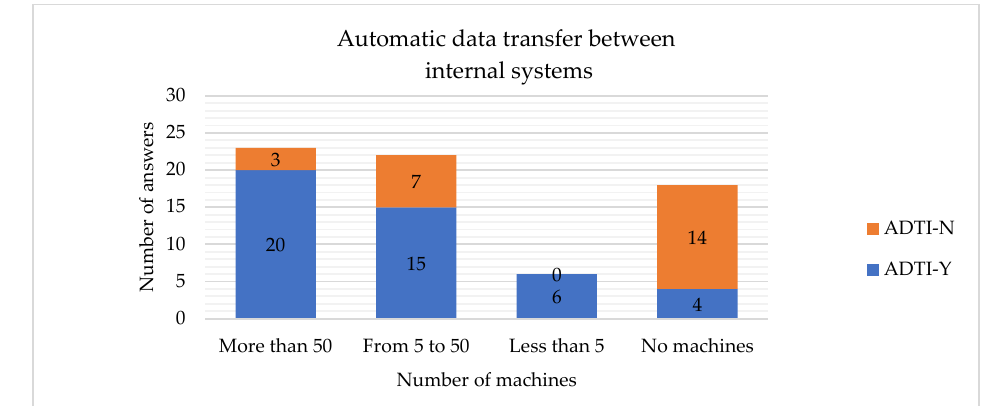
Figure 28. Number of companies having automatic data transfer between internal systems imple- mented (ADTI-Y) or not (ADTI-N) by number of machines.